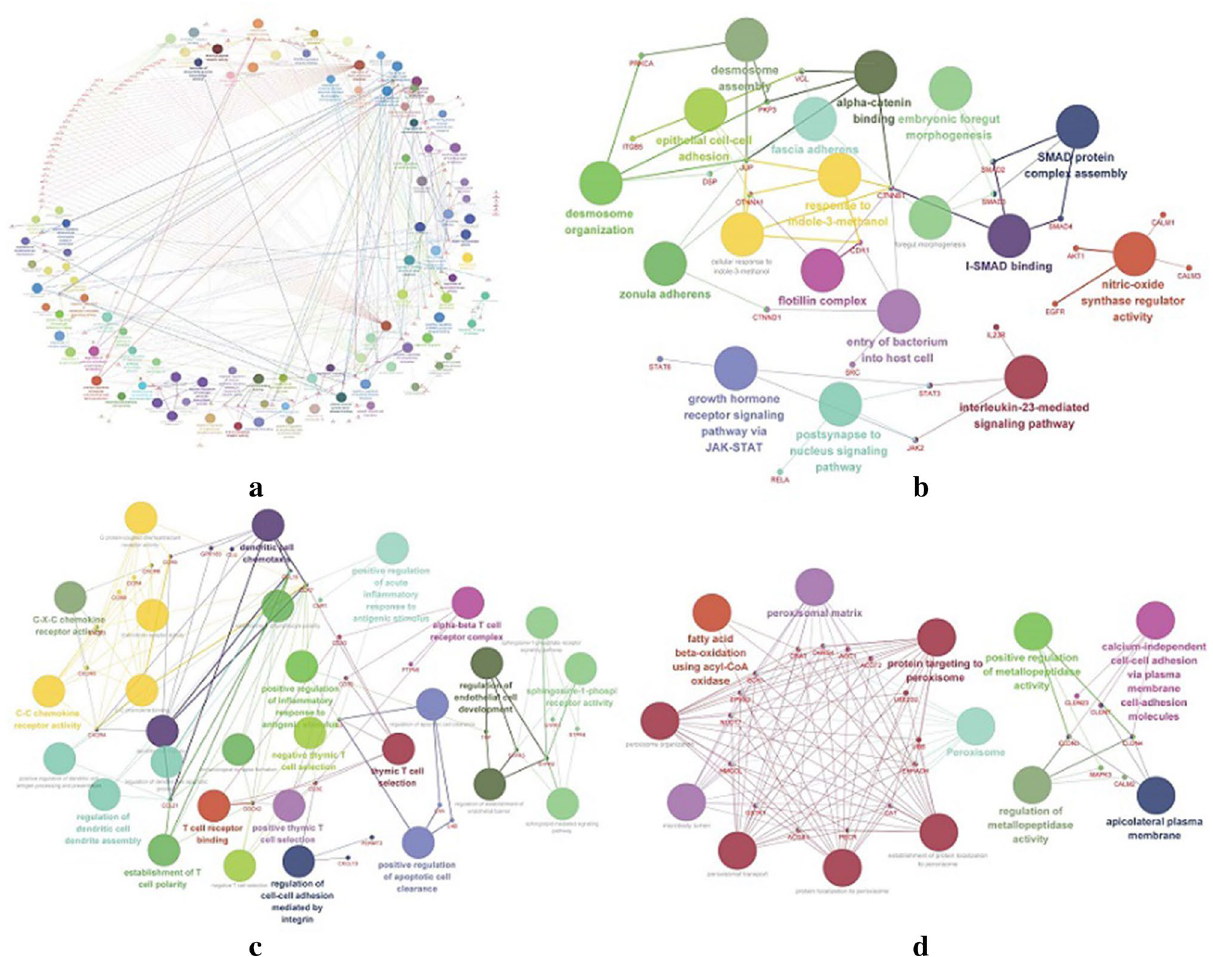
Figure 3. The diagram of GO and KEGG analysis. ( a ) shows the diagram of Turquoise module. ( b ) shows the diagram of Blue module. ( c ) shows the diagram of Brown module. ( d ) shows the diagram of Yellow module.